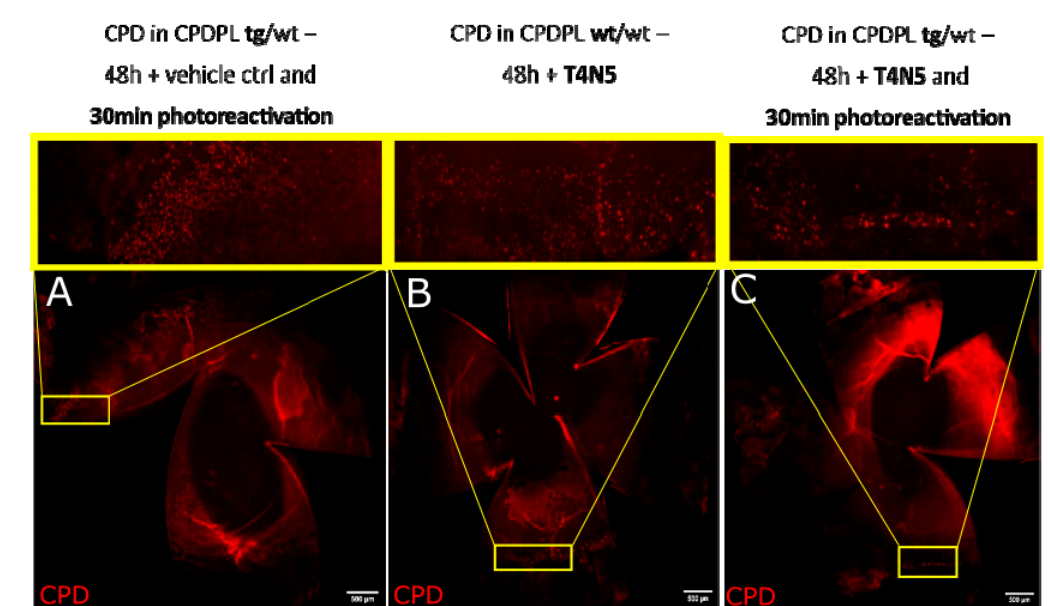
Figure 9. Images illustrating recovery of induced CPDs in control mice and CPDPL mutant mice following UVB exposure and either photoreactivation and 48 h with vehicle control ( A ) and T4N5 ( B ), or T4N5 and 30 min photoreactivation ( C ). CPDs stained red. Images were taken after 1 J/cm 2 UVB and 48 h of incubation. CPD immunofluorescence was highest in irradiated tissue treated with vehicle control.